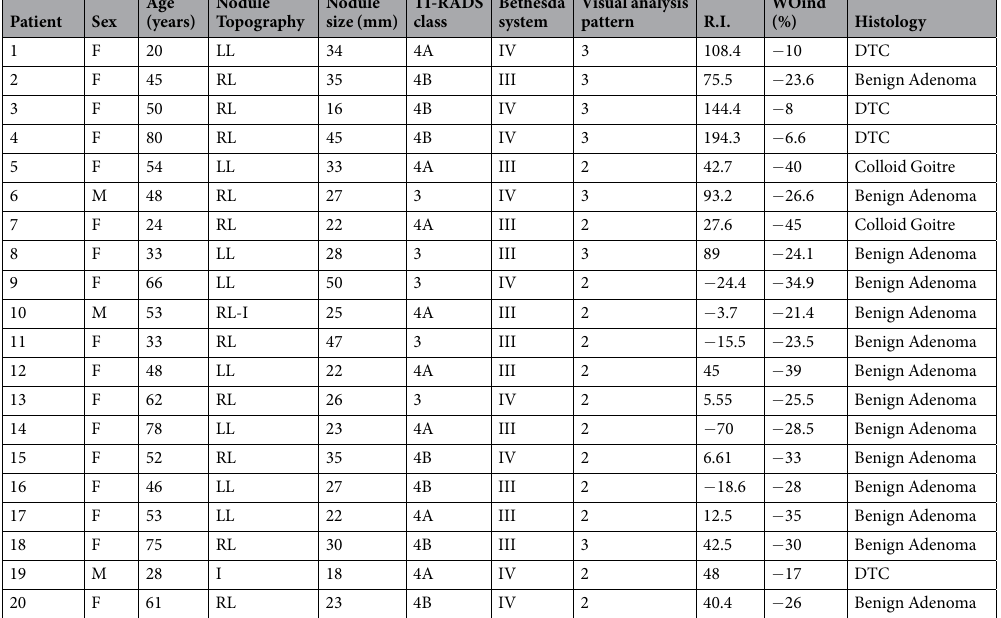
Table 1. Demographic, Clinical, Scintigraphic and Pathological data of the 20 patients included in the study. LL = Left Lobe; RL = Right Lobe; I = Isthmus; TI-RADS classification: 1 = normal; 2 = benign; 3 = probably benign; 4A = undeterminated pattern; 4B = suspicious pattern; 5 = consistent with malignancy. DTC = Differentiated Thyroid